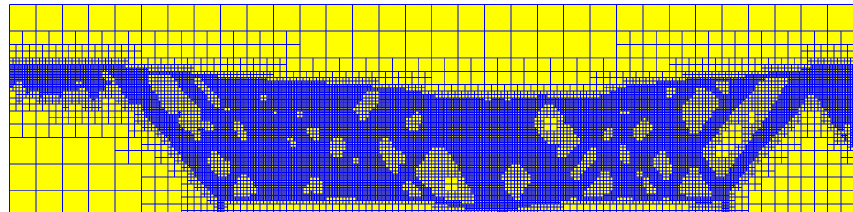
Figure 10. Numerical grid after ∼ 2cm of extension of the numerical sandbox. Adaptive mesh refinement and coarsening based on the viscosity and density leads to a minimum resolution of 6 . 25 × 6 . 25mm and a maximum resolution of 0 . 39 × 0 .